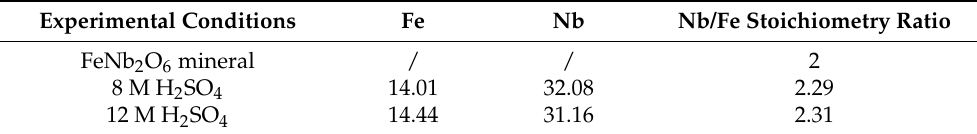
Table 1. ICP detection results of solution elements after different H 2 SO 4 acid leaching (mg/L). Experimental